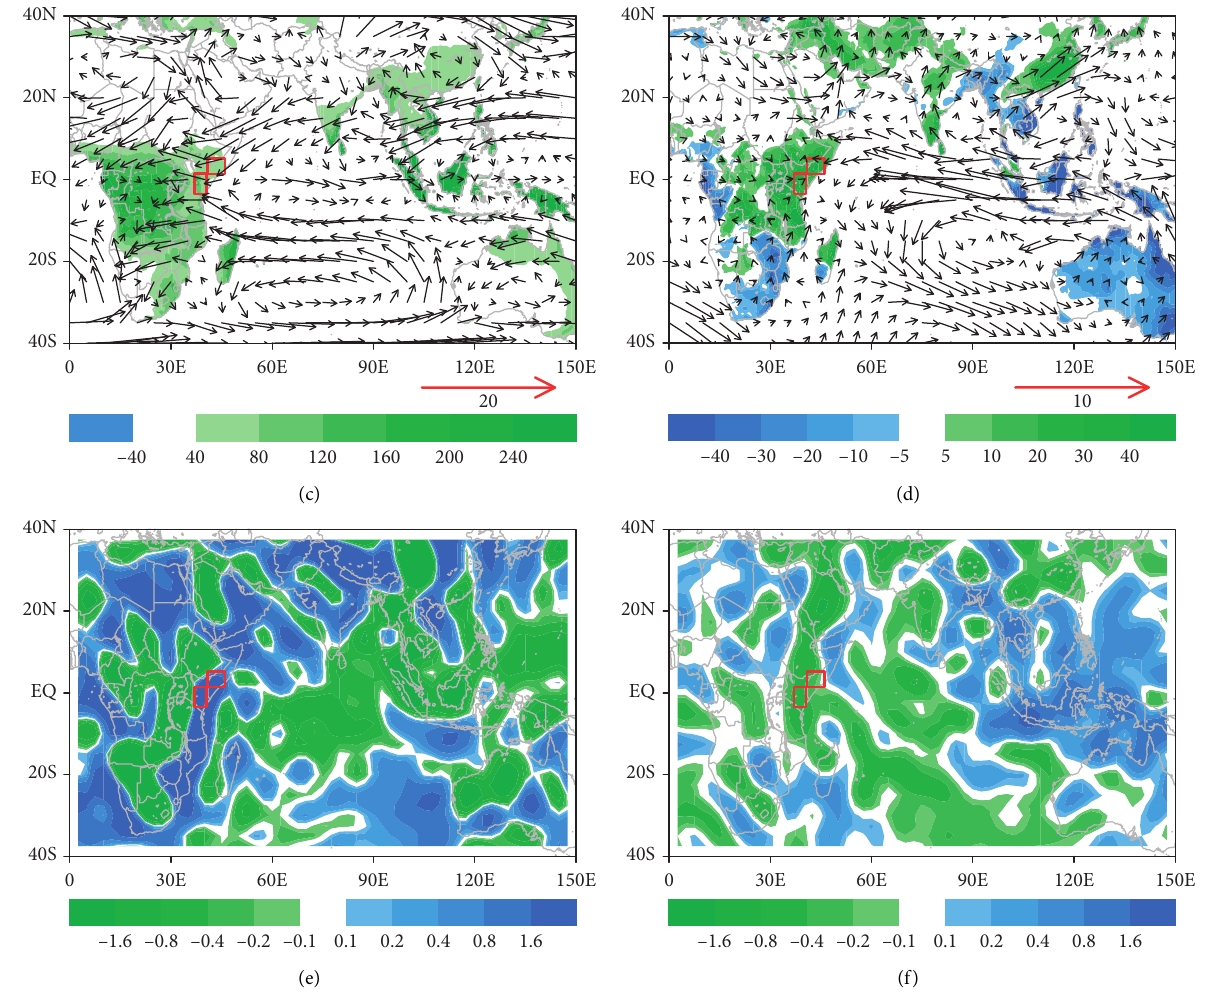
Figure 11: Same as Figure 9, but for OND season. (a) OND 200- hpa wind clim. (b) OND 200- hpa wind anomaly. (c) OND RF and 850-hpa wind clim. (d) OND RF and 850-hpa wind anomaly. (e) OND low-level divergence clim. (f) OND low-level divergence